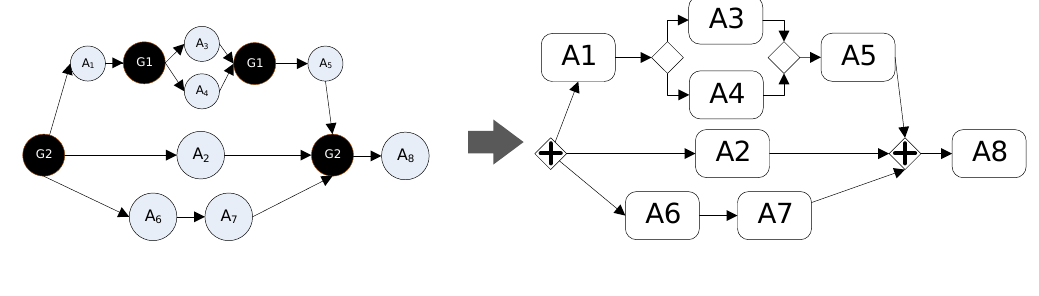
Figure 12. From graph to BPMN Model